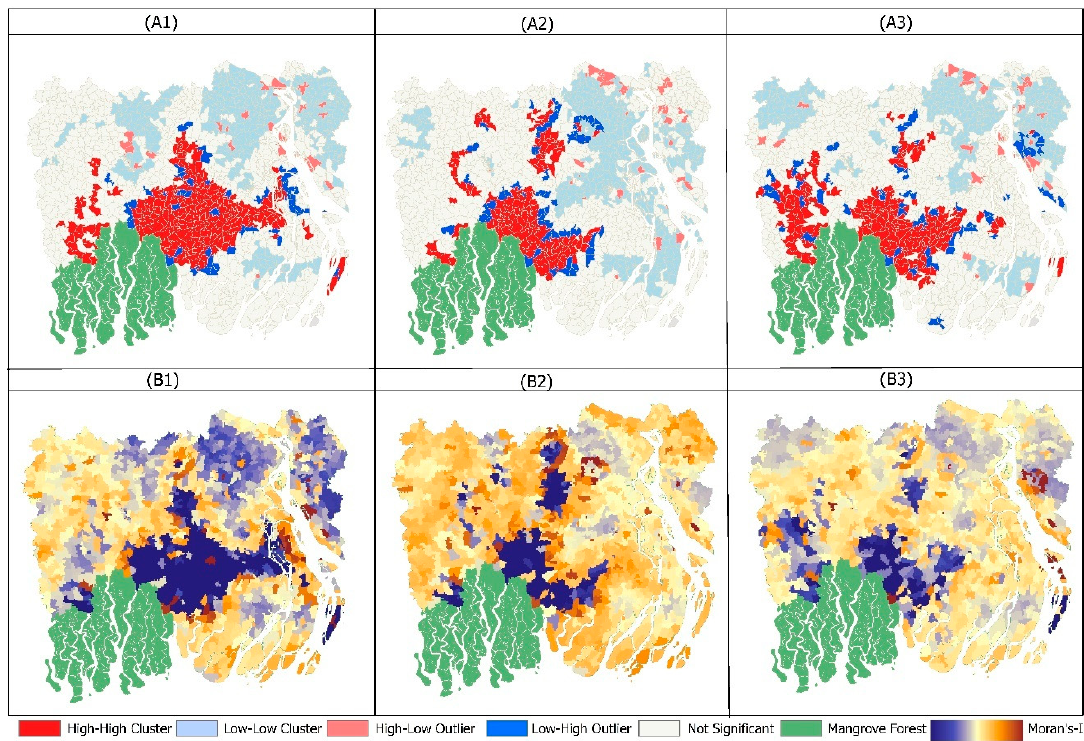
Figure 7. Local spatial cluster of flooding hotspots in ( A1 ) 22 May, ( A2 ) 28 May, and ( A3 ) 7 June. Red color in the map corresponds to a high cluster of floodwater with statistically significant p < 0.001. The bottom row of images shows the output of Moran’s I index, within the parameters of − 1 and +1. Similarly, ( B1 ) constitutes 22 May, ( B2 ) 28 May, and ( B3 ) refers to 7 June. The positive and negative values of Moran’s I characterize the change direction of target variables between neighboring and non-neighboring regions. The closer it is to 1, the stronger the positive autocorrelation of the data, the higher the regional agglomeration; the closer the value to 0, the more dispersed the spatial distribution.